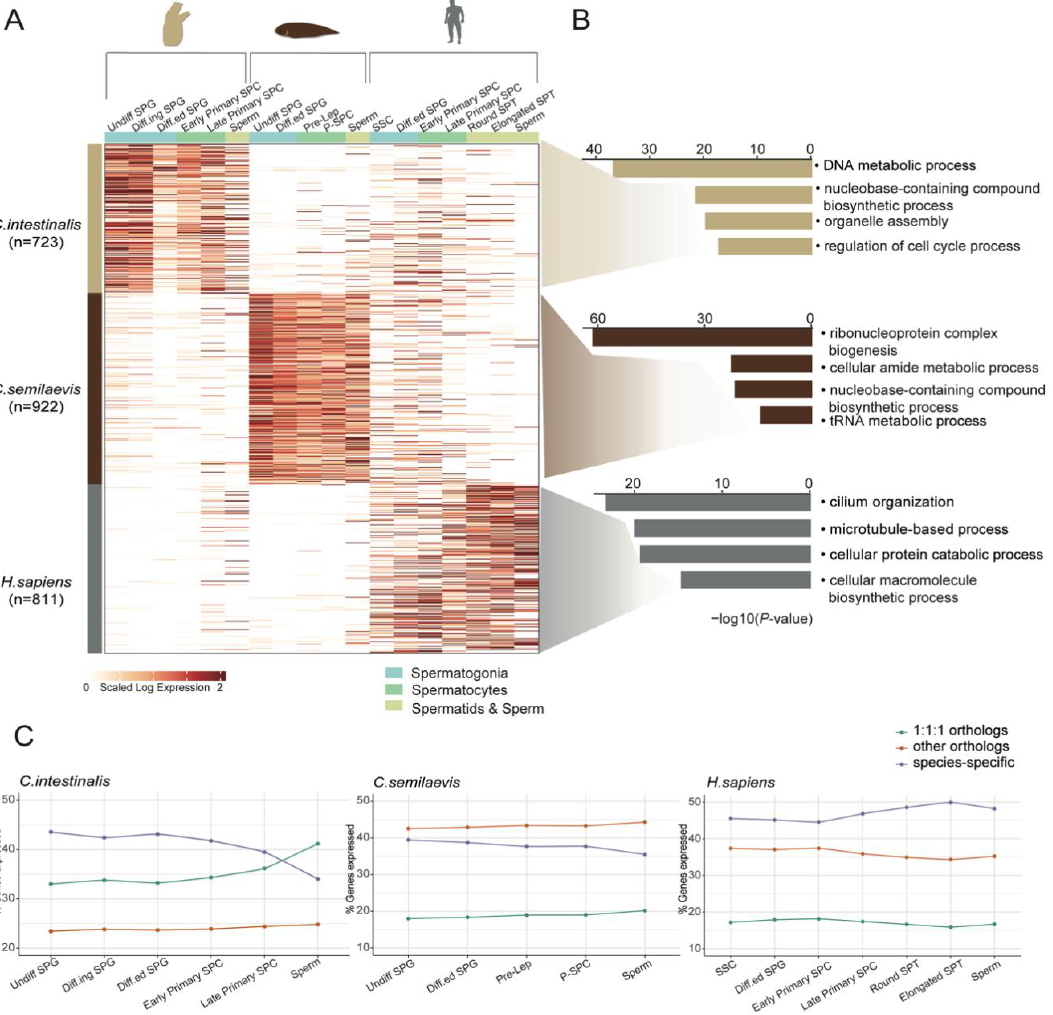
Figure 5. Species-specific evolutionary features of chordate spermatogenesis. ( A ) Heatmap showing the expression of differential gene orthologs among germ cells of the three species. ( B ) GO terms for the genes described in Figure 5A. ( C ) Line plot depicting the percentage of gene classes that are expressed in each species over the course of spermatogenesis, e.g., 1-1-1 orthologous genes (green), other orthologs (orange), and species-specific genes